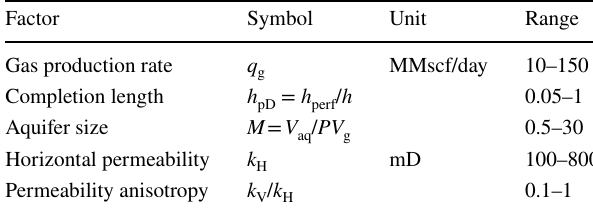
Table 5 Studied range of production and reservoir